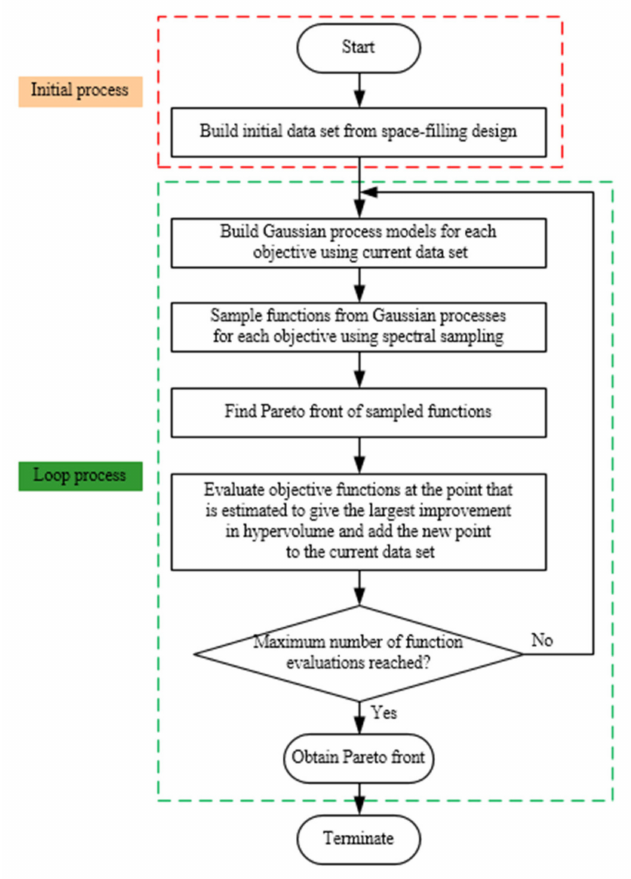
Figure 7. Algorithm flowchart for TSEMO